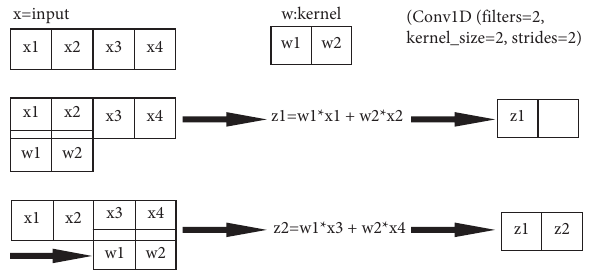
Figure 4: Convolutional layer execution